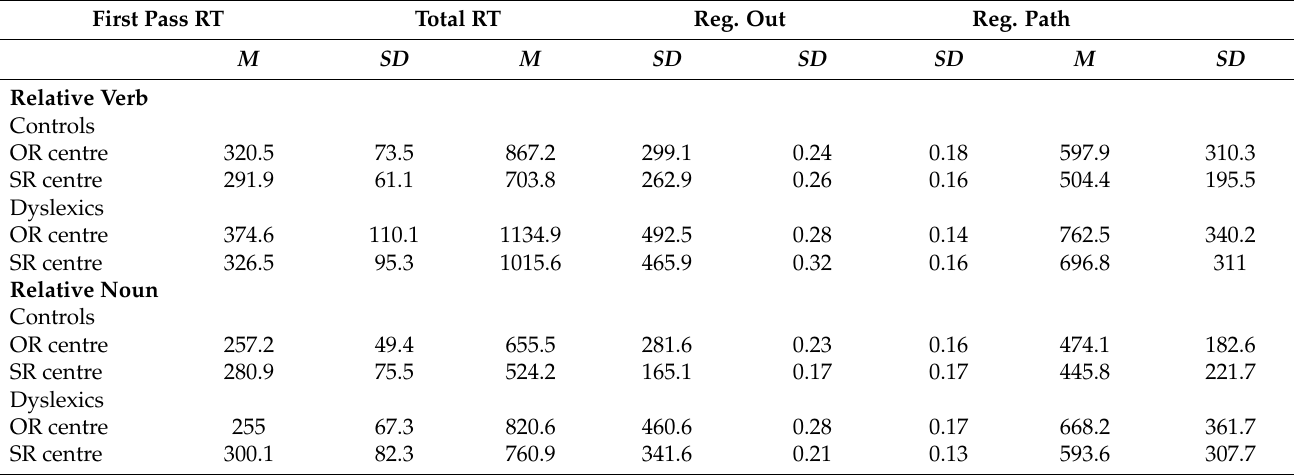
Table 5. Mean reading times clause by group and experimental condition-relative